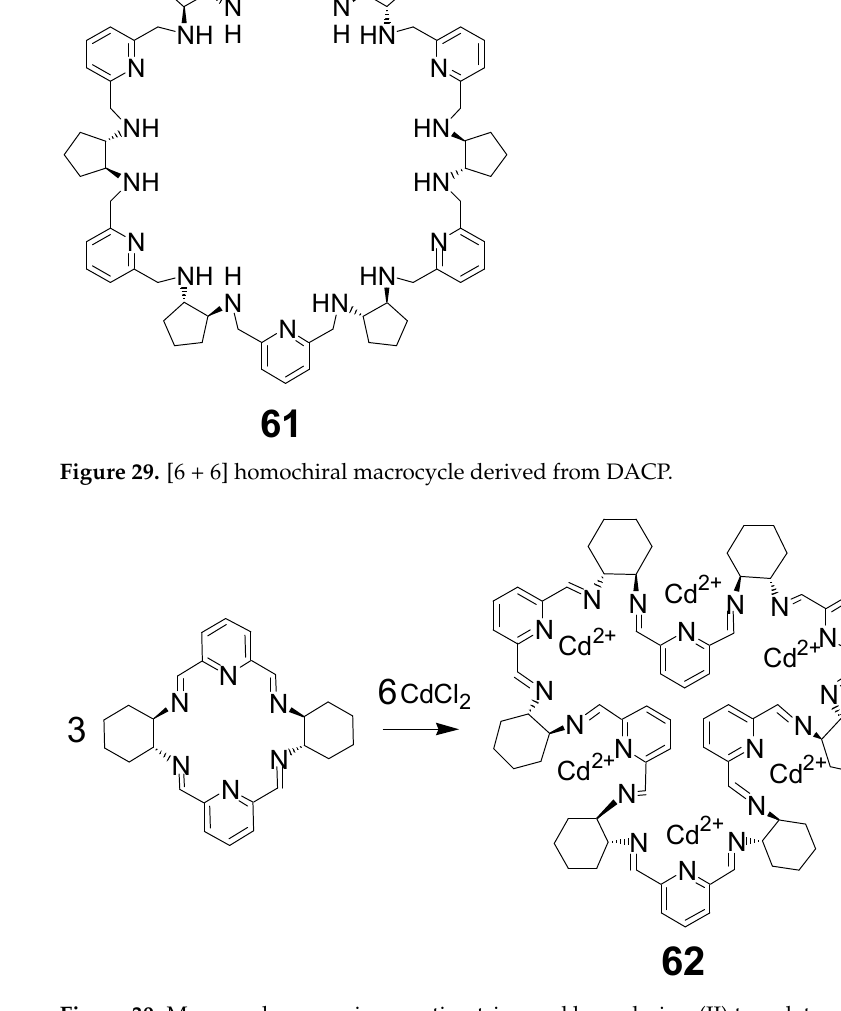
Figure 30. Macrocycle expansion reaction triggered by cadmium(II) template.